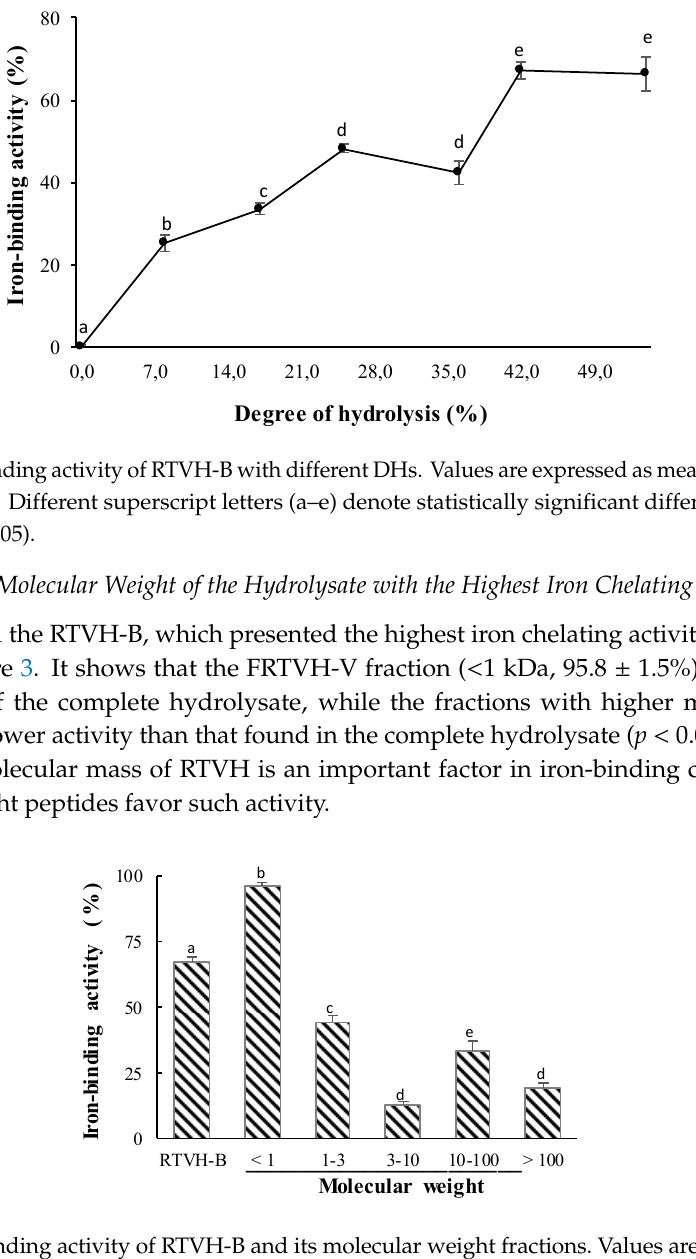
Figure 4. IC 50 of RTVH-B, its fraction FRTVH-V, and EDTA. Different superscript letters denote statistically significant differences among treatments ( p < 0.05). EDTA is one of the most important synthetic chelating agents in the industry, because of its high capacity to form coordinated complexes with most multivalent metal ions [28]. Therefore, the fact that the IC 50 of the FRTVH-V fraction is in the same order of magnitude as EDTA implies that this fraction has high potential for application in the industry. 3.4. Bioavailability of Iron 3.4.1. Cytotoxicity Analysis